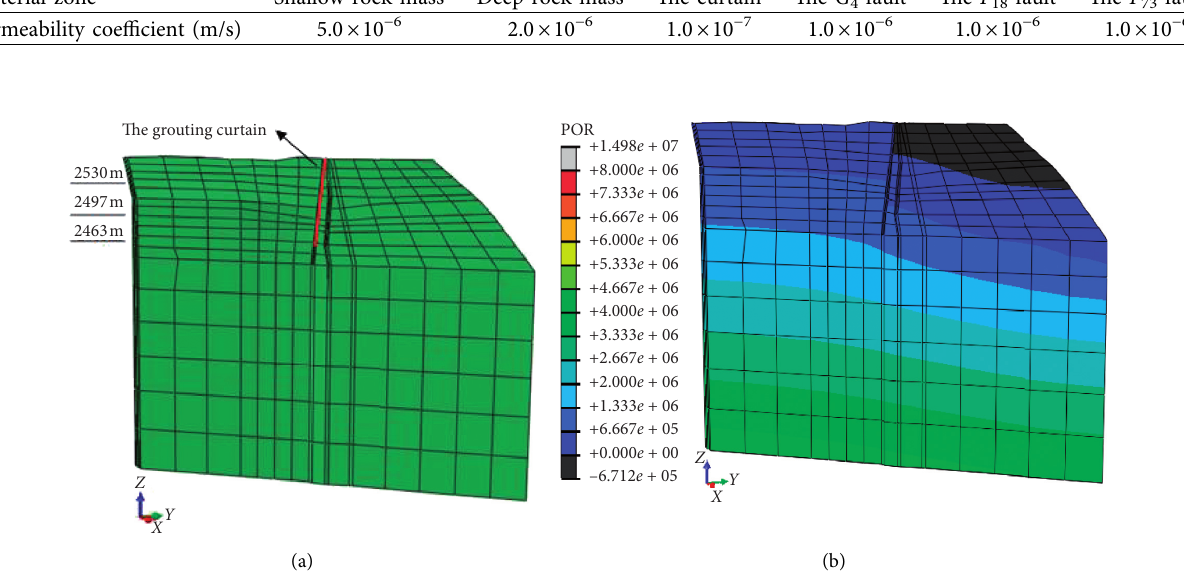
Figure 18: The F 120 + A 2 fault model and the calculated saturation lines. (a) Seepage extraction cross section; (b) the saturation line with water level of 2597.62 m.